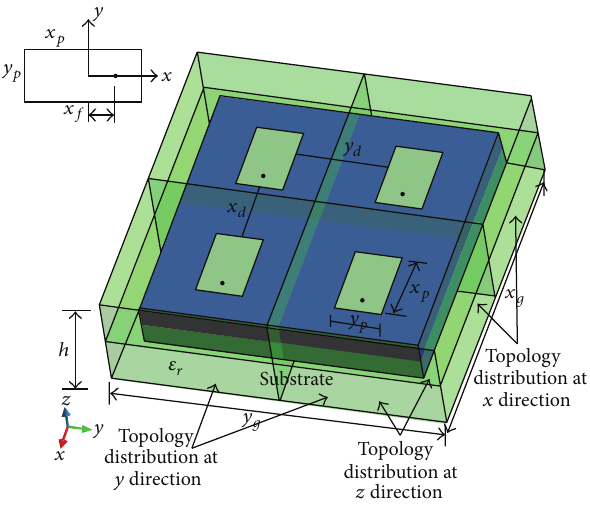
Figure 1: 2 × 2 microstrip array.